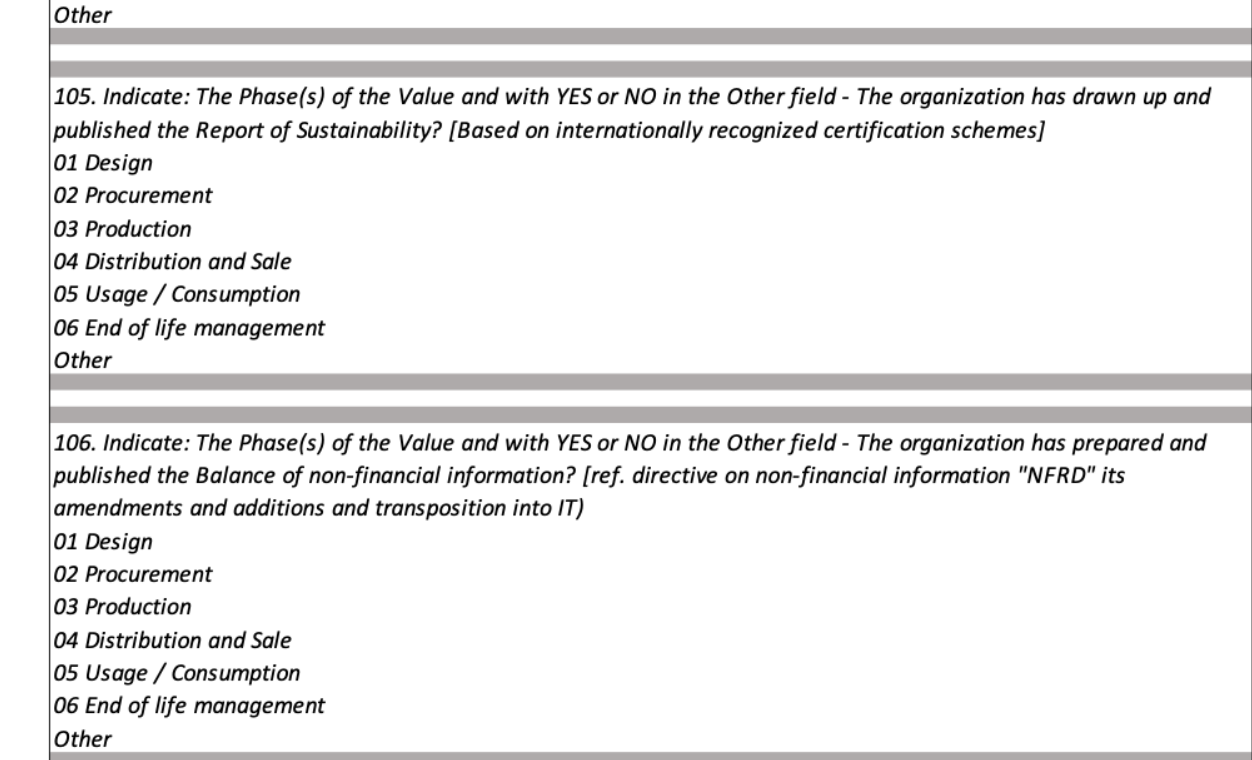
Figure 4. Example of indicators for the “Management of Human Resources, Assets, Policy, and Sustainability” category (Source: Questionnaire for UNI1608856 early-stage